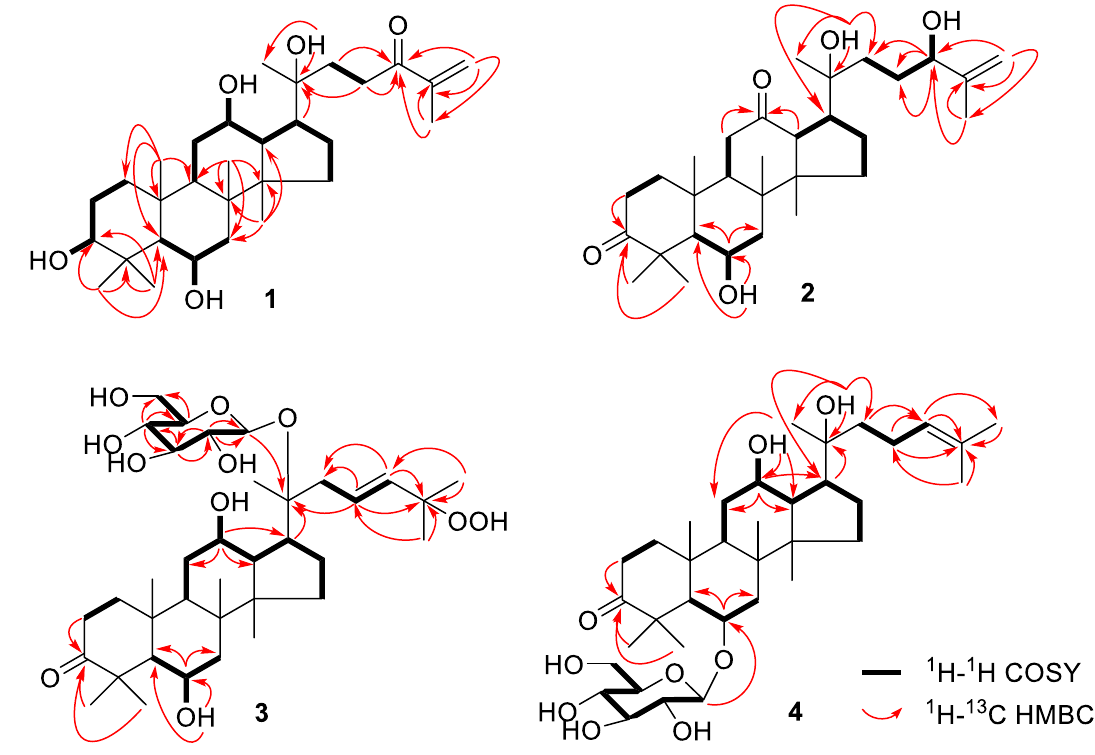
Fig. 2 Key 1 H- 1 H COSY and 1 H- 13 C HMBC correlations of compounds 1 –